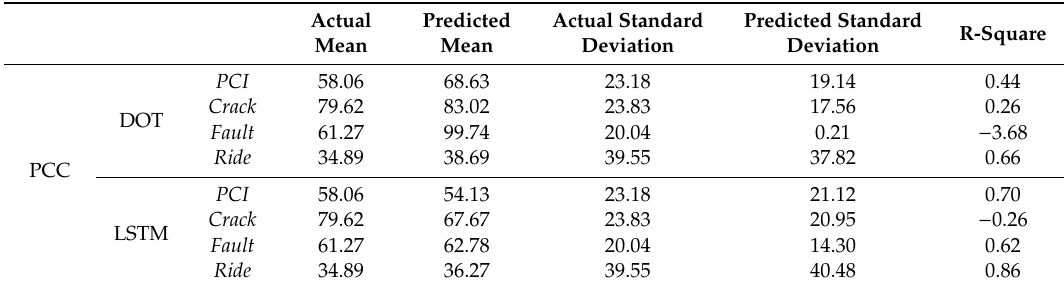
Table 4. Summary statistic of each model on the test